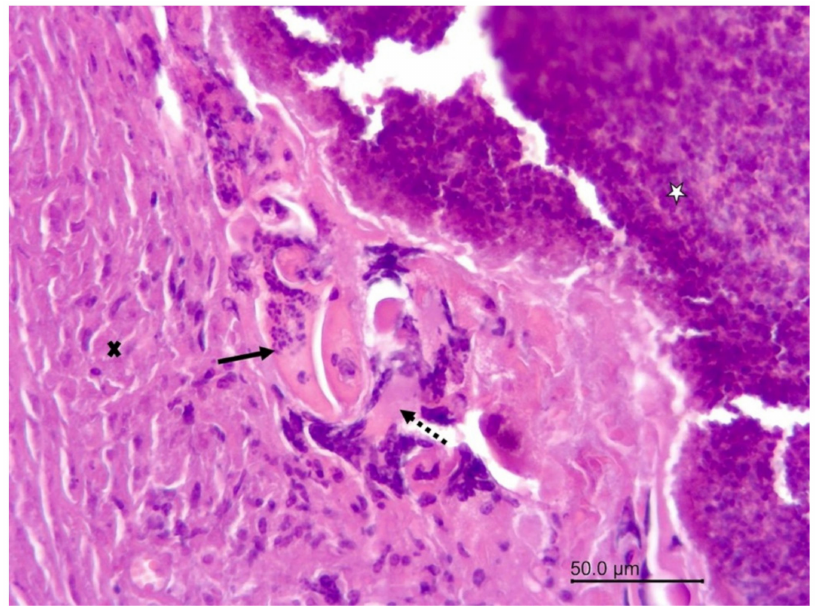
Figure 1. Wapiti, case 1, liver, histopathology, HE, × 200. Structures resembling parasitic larvae (full arrow) between the fibrous capsule (cross) and necrotic inflammatory cells in the center of the granuloma (star), and around these structures are giant cells (dashed arrow) and macrophages.